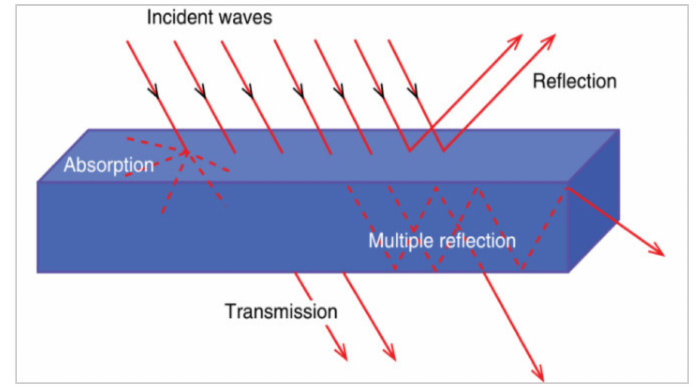
Figure 2. Mechanism of electromagnetic